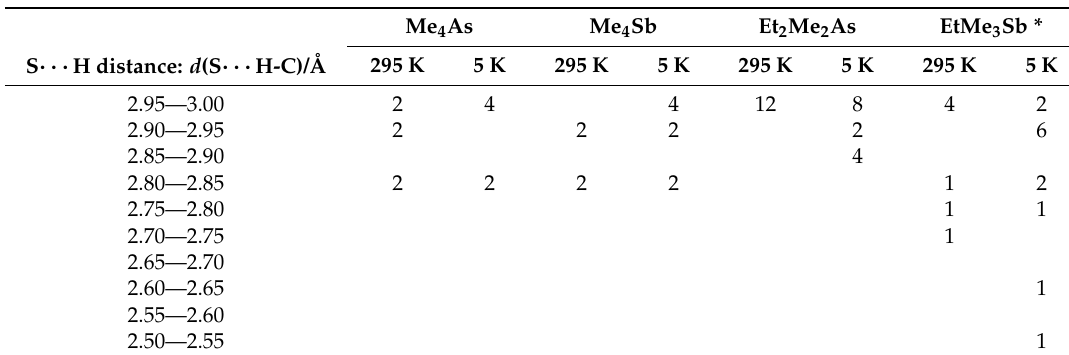
Table 2. The number of short S · · · H-C contacts between the cation and terminal thioketone of the Pd(dmit) 2 molecule at 295 K and 5